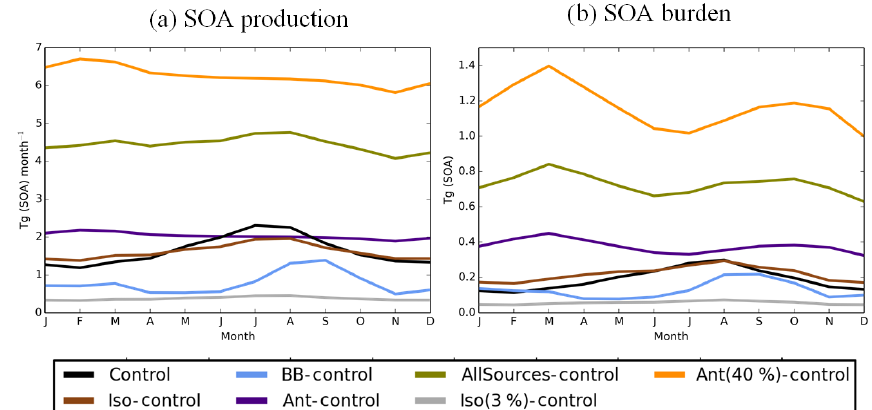
Figure 4. Monthly average global SOA (a) production (Tg(SOA) month − 1 ) and (b) burden (Tg (SOA)), simulated by UKCA for the control simulation in black. For the other UKCA simulations described in Table 2, the monthly average global SOA production and burden are shown relative to the control simulation.